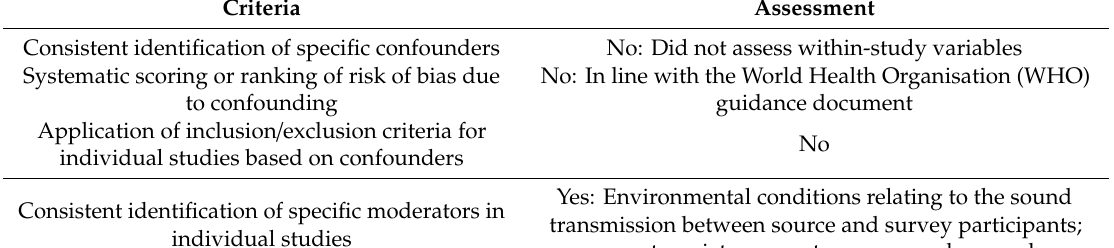
Table 2. Assessment matrix for